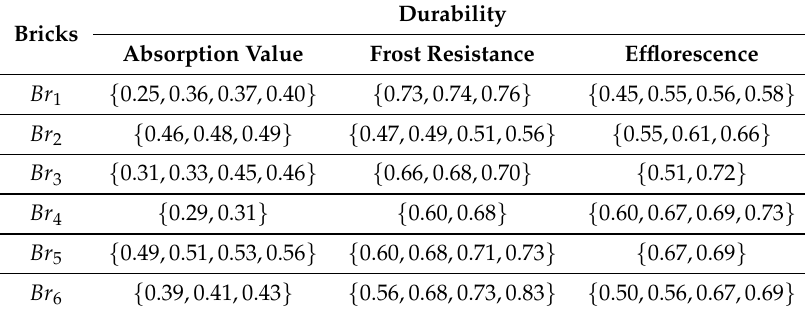
Table 3. Tabular representation of optimistic 3HF decision matrix by adding maximal